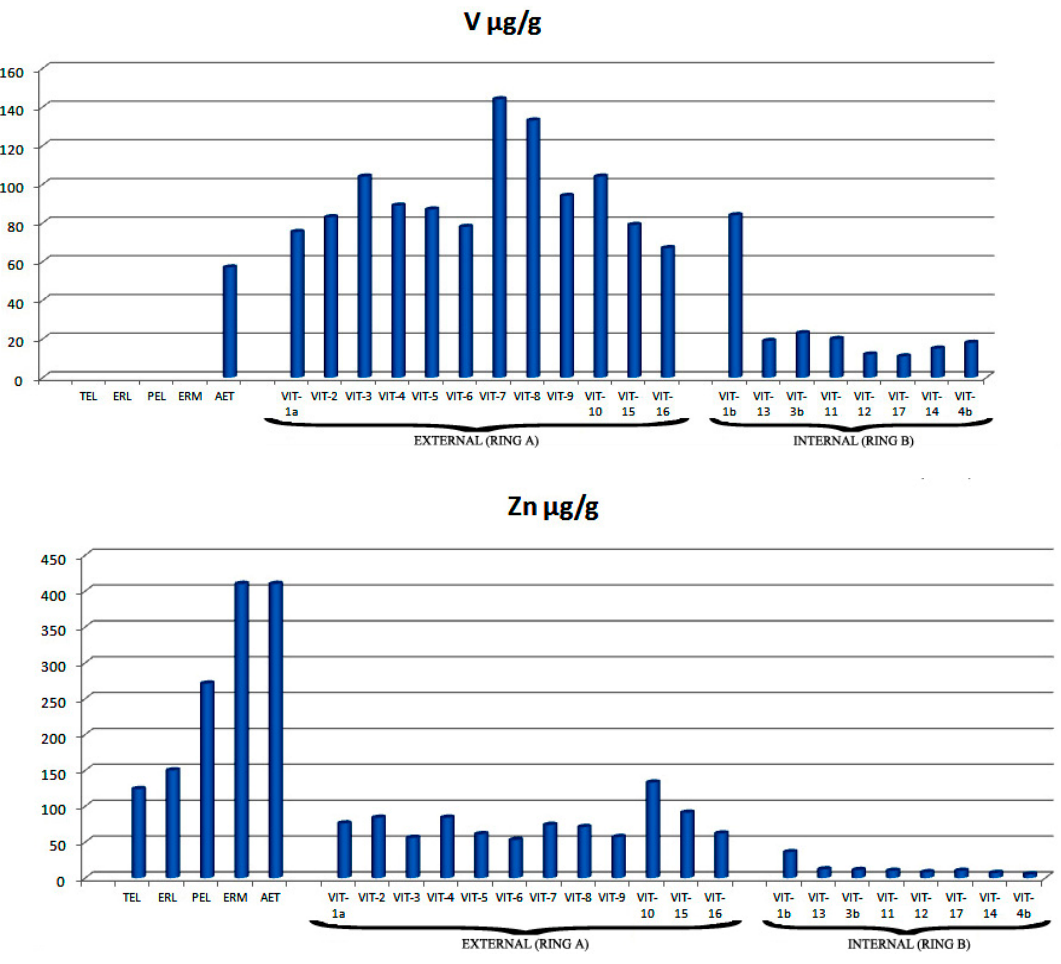
Figure 6. Silver, aluminum, arsenic, barium, chromium, iron, manganese, nickel, lead, antimony, vanadium, and zinc distributions compared to the benchmark values Threshold effects levels (TELs), effects range low (ERL), probable effects levels (PELs), effects range median (ERM), and apparent effects thresholds (AETs), while stations are named “VIT-“, after “Vitória”.